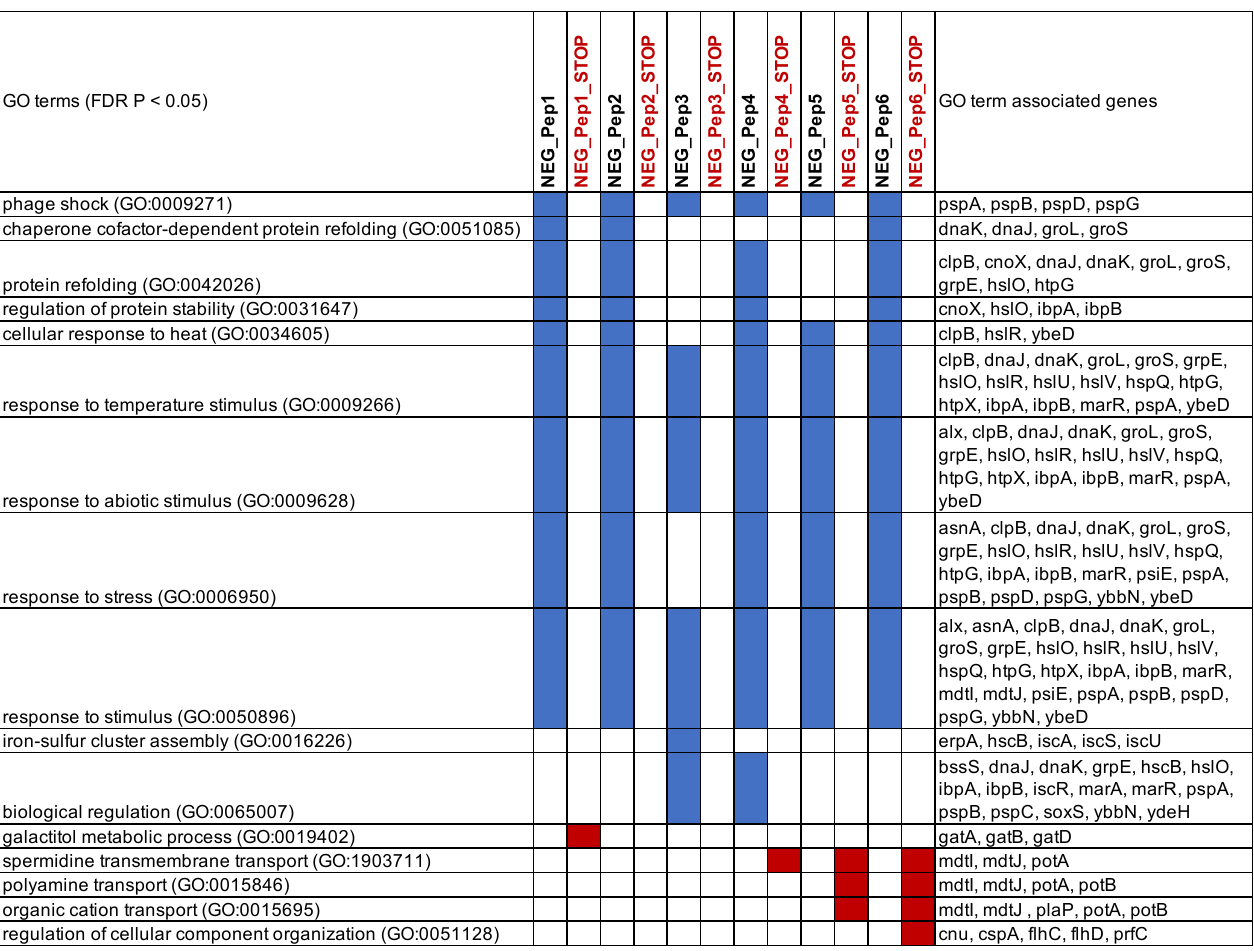
Figure 5. Major GO enrichment categories for the genes with the highest fold change in cells expressing NEG_Pep clones. Categories are listed with FDR p < 0.05; redundant categories were removed. GO terms were extracted using the GO enrichment analysis tool using Panther version 16.0. Blue and red marks indicate that the respective GO categories were found for the NEG_Pep listed in the respective column. The GO term-associated gene list is cumulative for all clones that show the respective GO term.